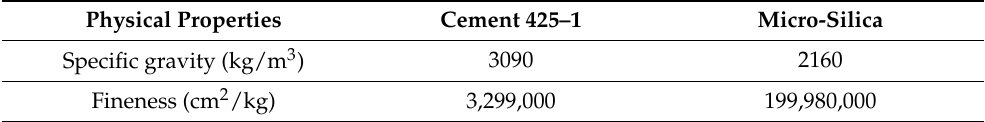
Table 1. Physical properties of cement and silica fume